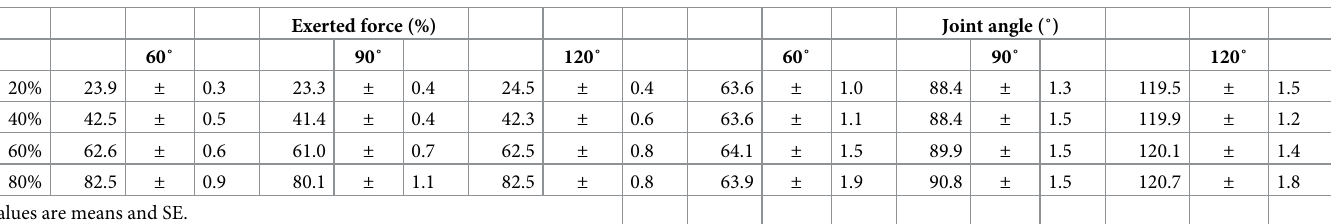
Table 1. Exerted force and joint angle during elbow extension